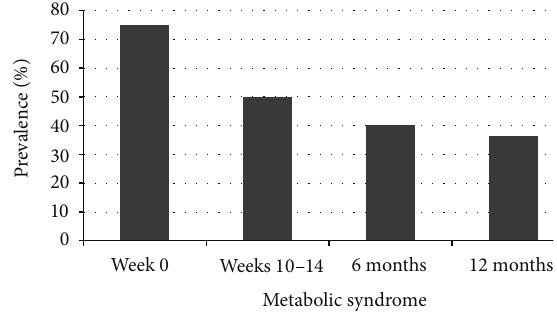
Figure 5: The prevalence of metabolic syndrome within the ILI- group at week 0, weeks 10–14, six, and 12 months (𝑛 = 52) . 𝑃 < 0.0001 for change in the proportion of participants diagnosed with metabolic syndrome across the four measurement time points (Cochran’s Q test).